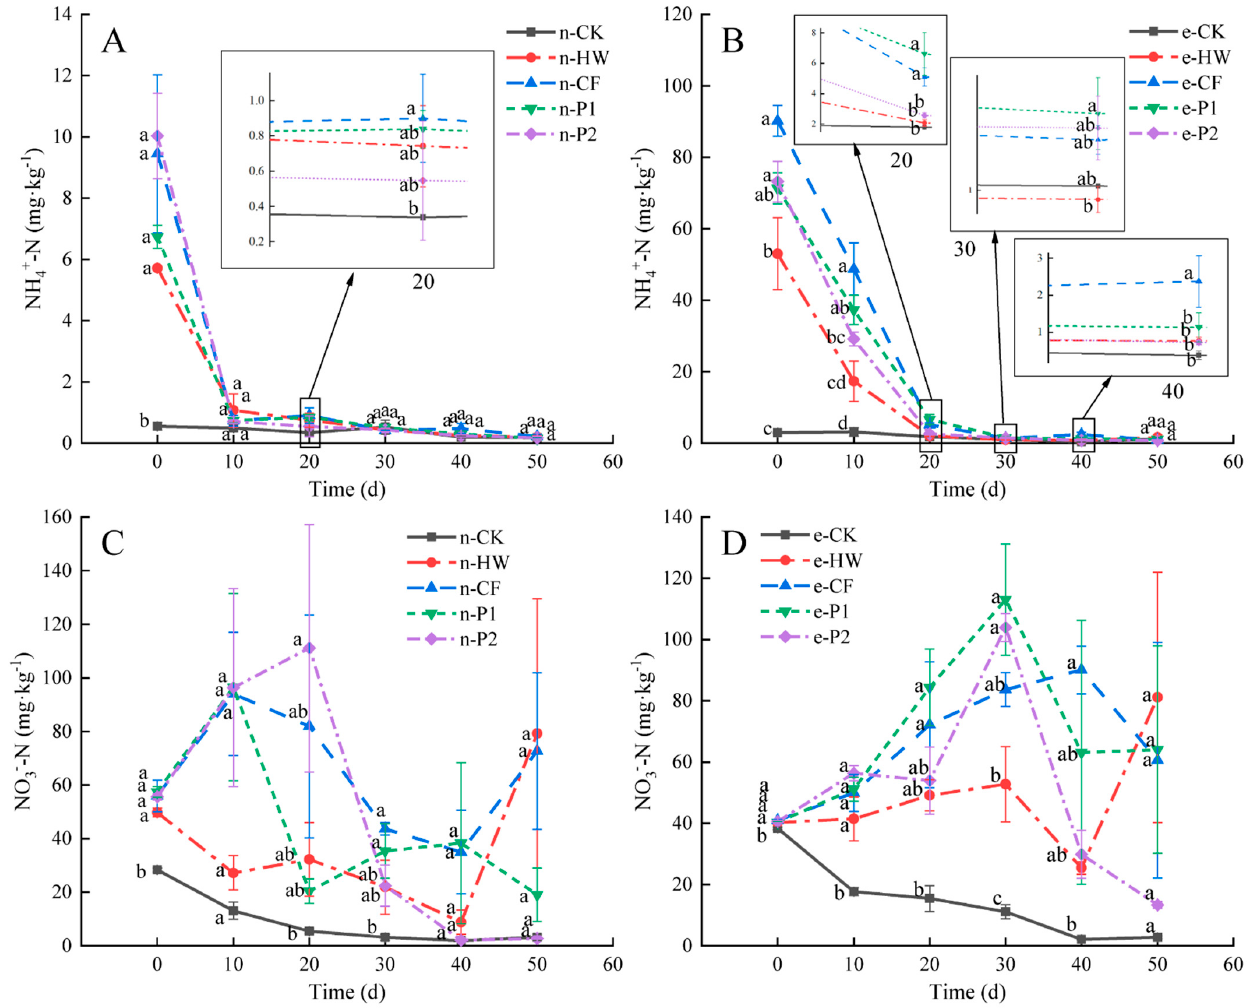
Figure 1. ( A ) and ( C ) are the changes of NH 4+ -N and NO 3 − -N in soil of Cambisols at different periods, and ( B ) and ( D ) are the changes of NH 4 + -N and NO 3 − -N in soil of Alisols at different periods. “n” represents the treatment of soil Cambisols, and “e” represents the treatment of soil Alisols. CK = no fertilization; HW = human waste application; CF = chemical fertilizer application; P1 = 1/3 human waste to chemical fertilizer; P2 = 2/3 human waste to chemical fertilizer. The mean value accompanying the same letter in the same period (N = 3) in Duncan’s multiple range test showed no statistically significant difference ( p =